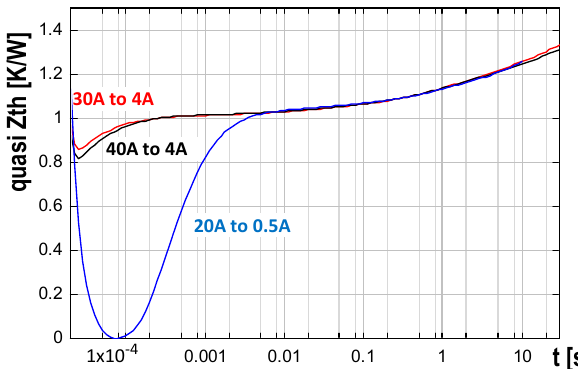
Figure 13. The “quasi Z th ” curves of the measurement on the experimental Digital Signal Processor device and normalized transients without correction of the initial electric portion, at different I HEAT and I SENSE levels.